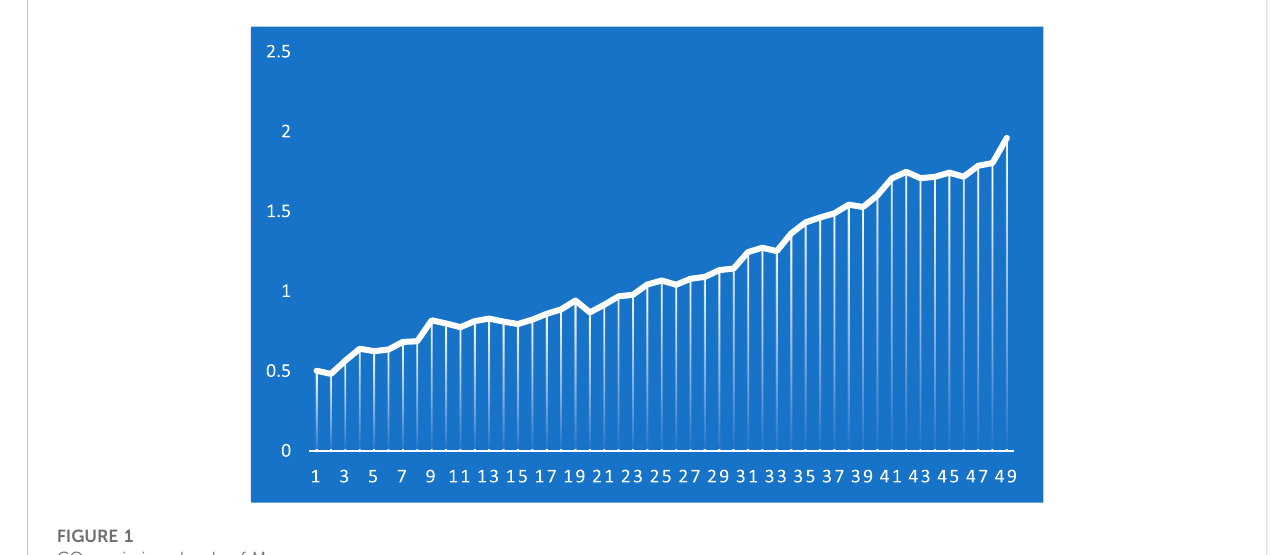
FIGURE 1 CO 2 emissions levels of